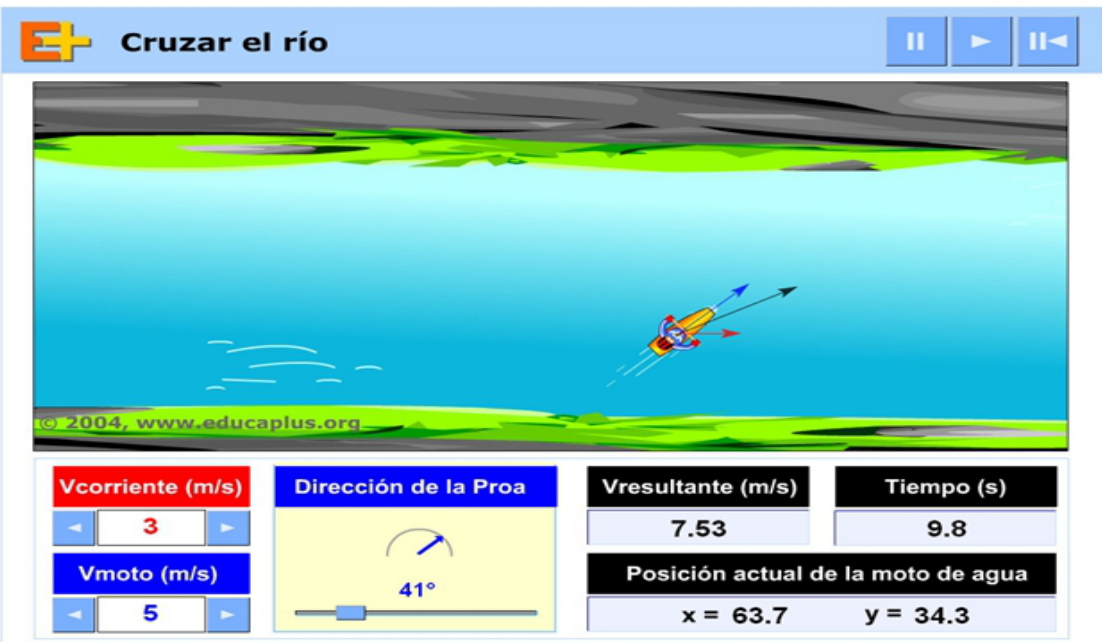
Figure 2. Screenshot from applet No. 2, ‘Crossing the river’ (= ‘Cruzar el río’) about composition of velocities, during running